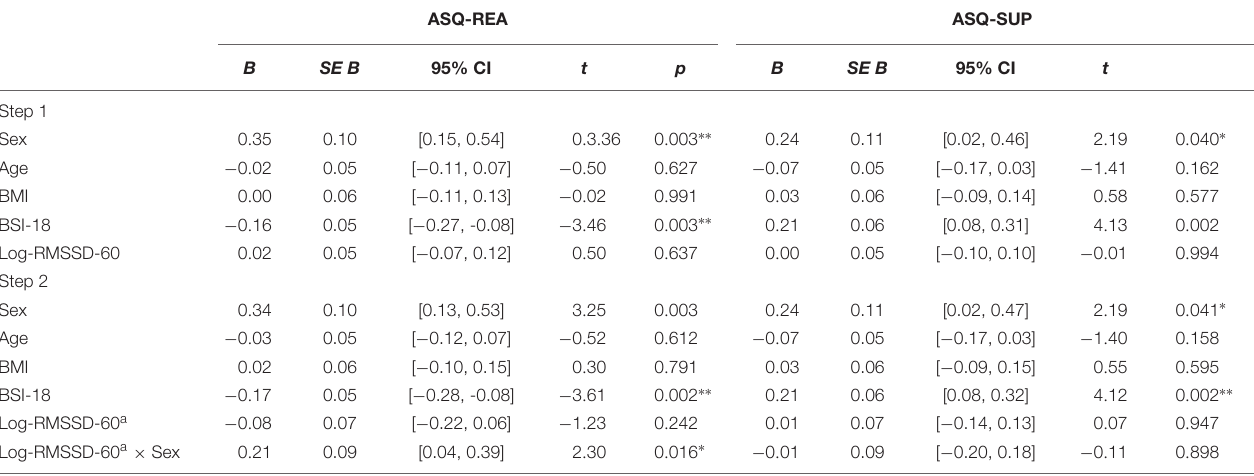
TABLE 4 | Associations between ultra-short term measures of heartrate variability that had been derived from 60 s lasting heartrate recordings and measures of reappraisal and suppression use.